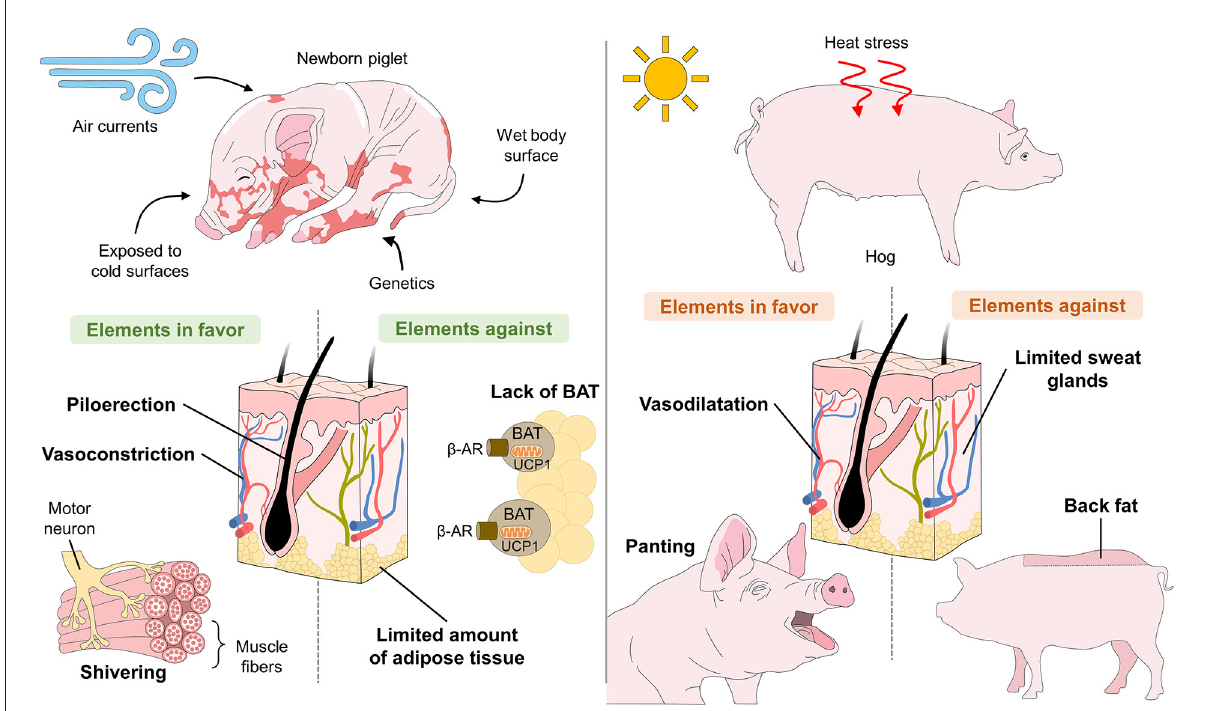
FIGURE2 Anatomical-physiological challenges of piglets related to hypothermia and of hogs related to